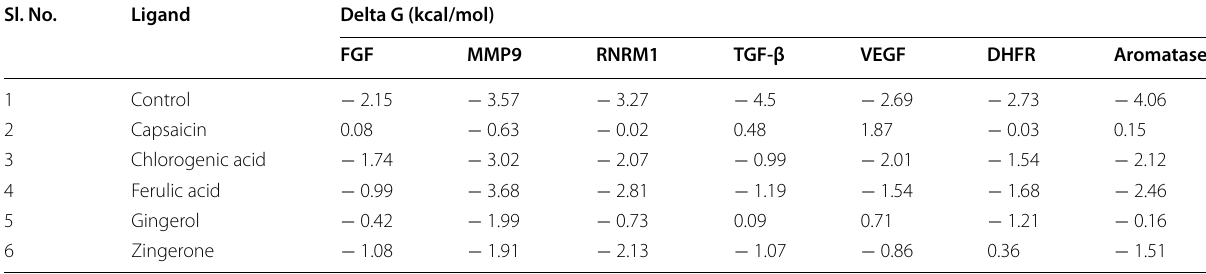
Table 1 Delta G value obtained from the molecular interaction of selected cancer receptors with respective control and curcumin analogues Sl.